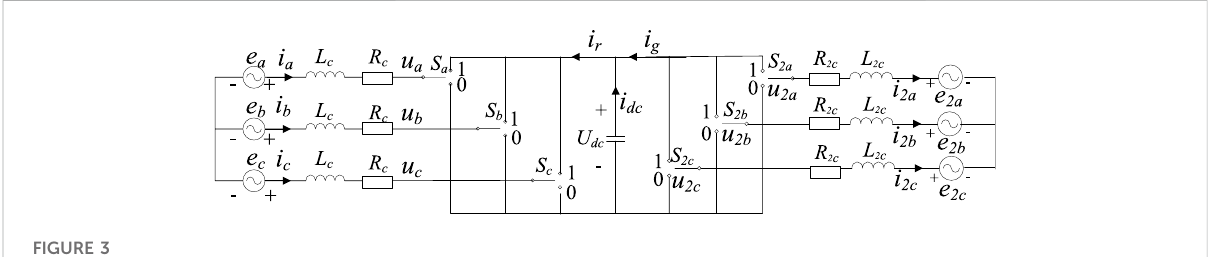
FIGURE 3 PWM converter main circuit simpli fi ed model.